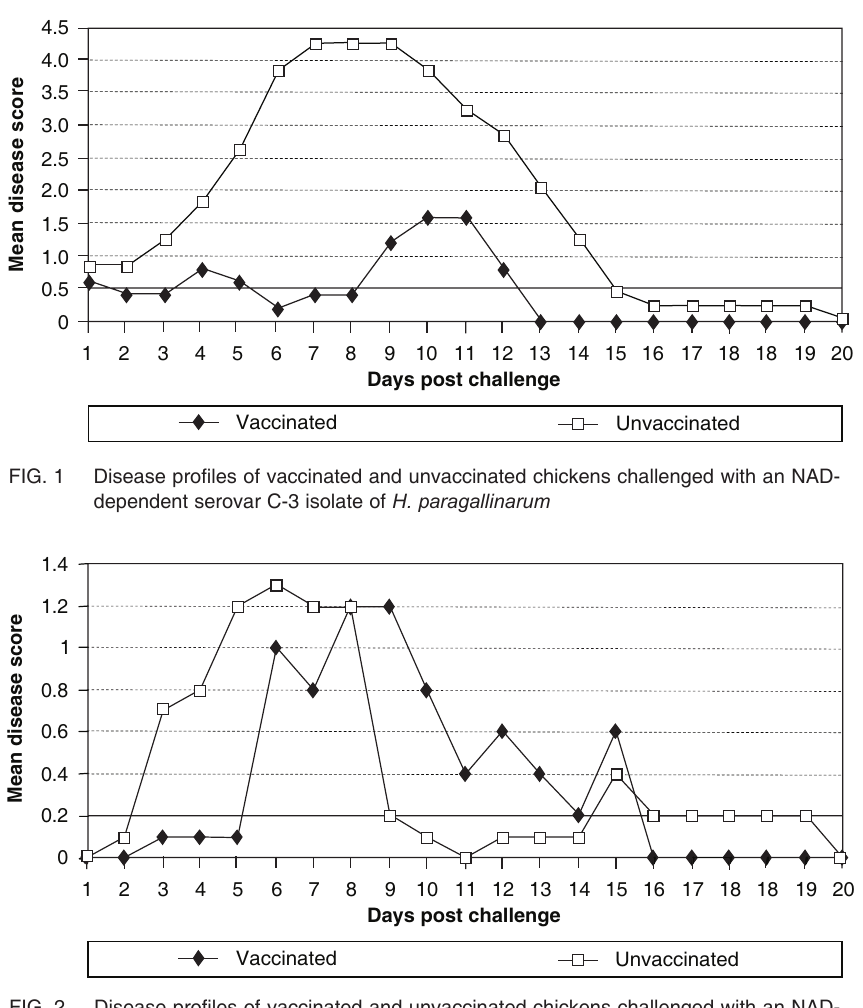
FIG. 2 Disease profiles of vaccinated and unvaccinated chickens challenged with an NAD- independent serovar C-3 isolate of H.